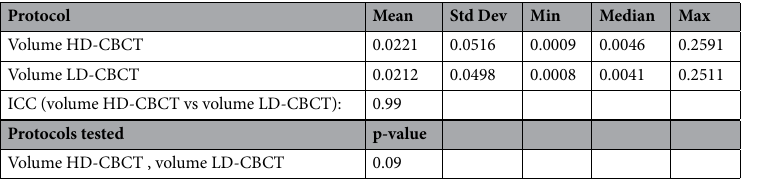
Table 3. Means, medians, ICC-value and p-value of furcation volume measurements. Std Dev standard deviation, Min minimum, Max maximum.